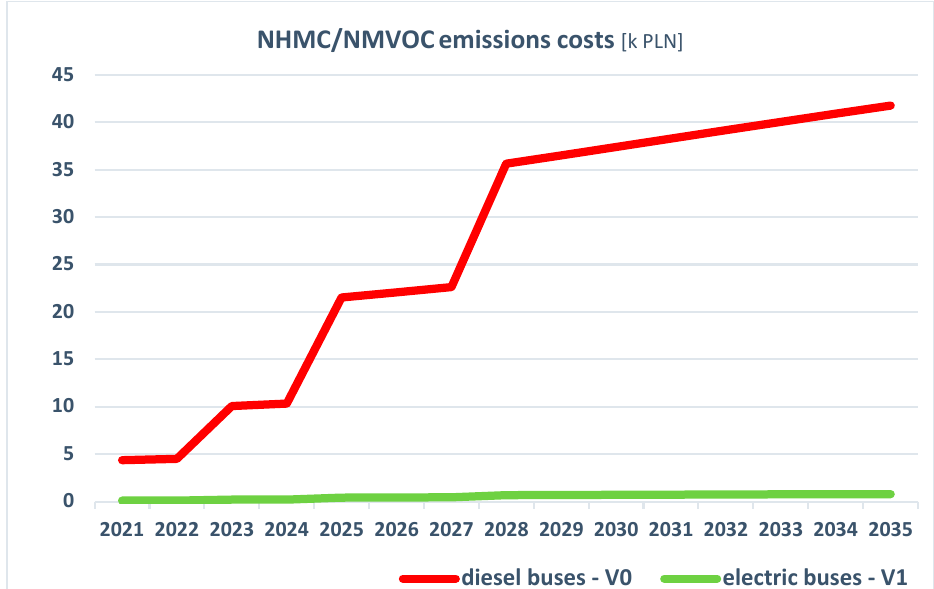
Figure 4. Projected amounts of NHMC/NMVOC emissions costs of the public bus fleet in Szczecin in the 2021–2035 period for variants V0 and V1.